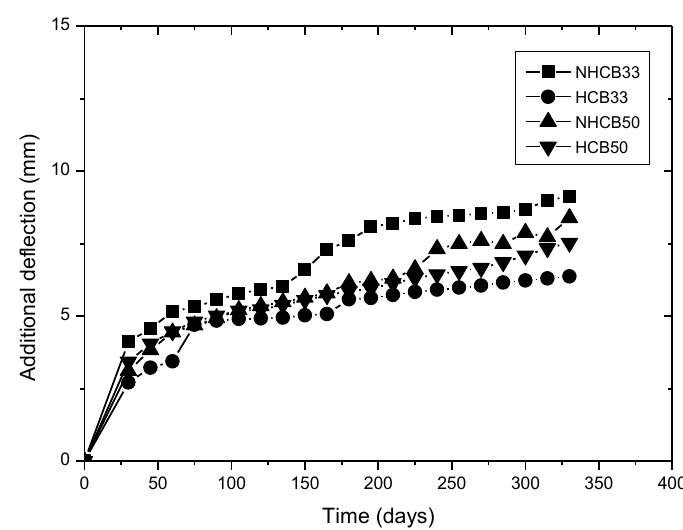
Figure 6. Additional deflections under two different sustained loadings.